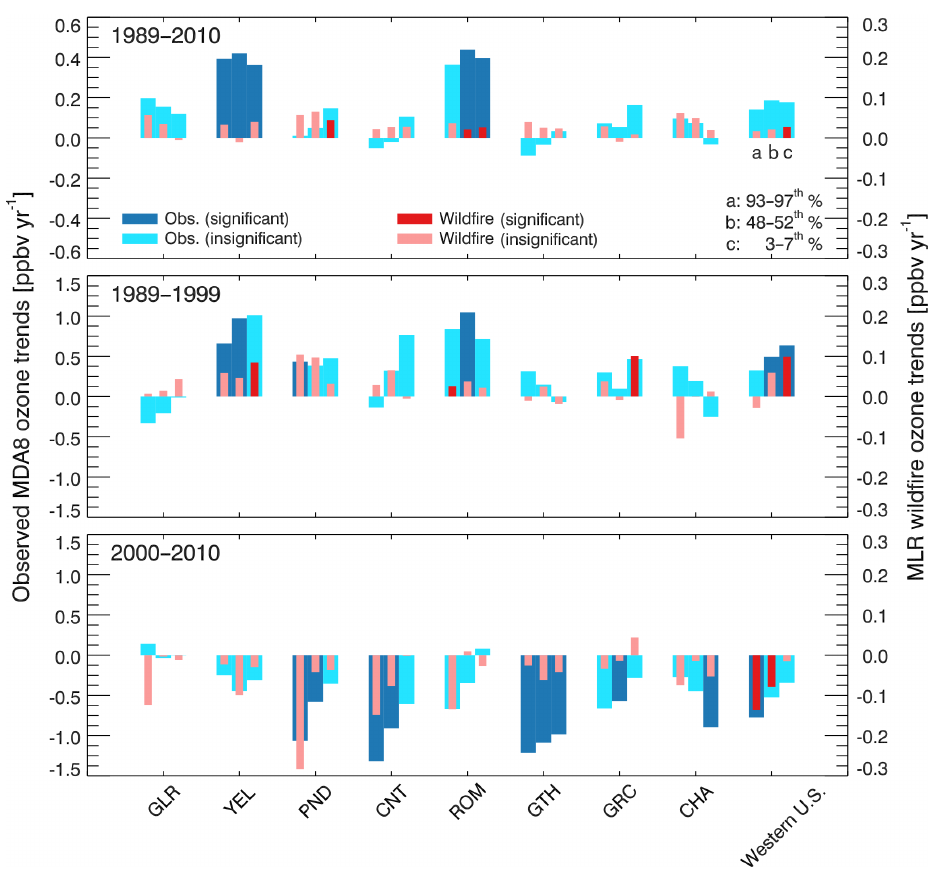
Figure 8. Linear trends of summer mean MDA8 ozone concentrations (blue bars, left axis) for 1989–2010 (top panel), 1989–1999 (middle panel), and 2000–2010 (bottom panel) at eight CASTNet sites and for the Intermountain West regional averages for the (a) 93–97th, (b) 48–52th, and (c) 3–7th percentile ranges. Also shown are the trends contributed by wildfire ozone enhancements (red bars, right axis) as computed by the MLR models. Statistically significant trends ( p< 0 . 05) are emphasized in dark